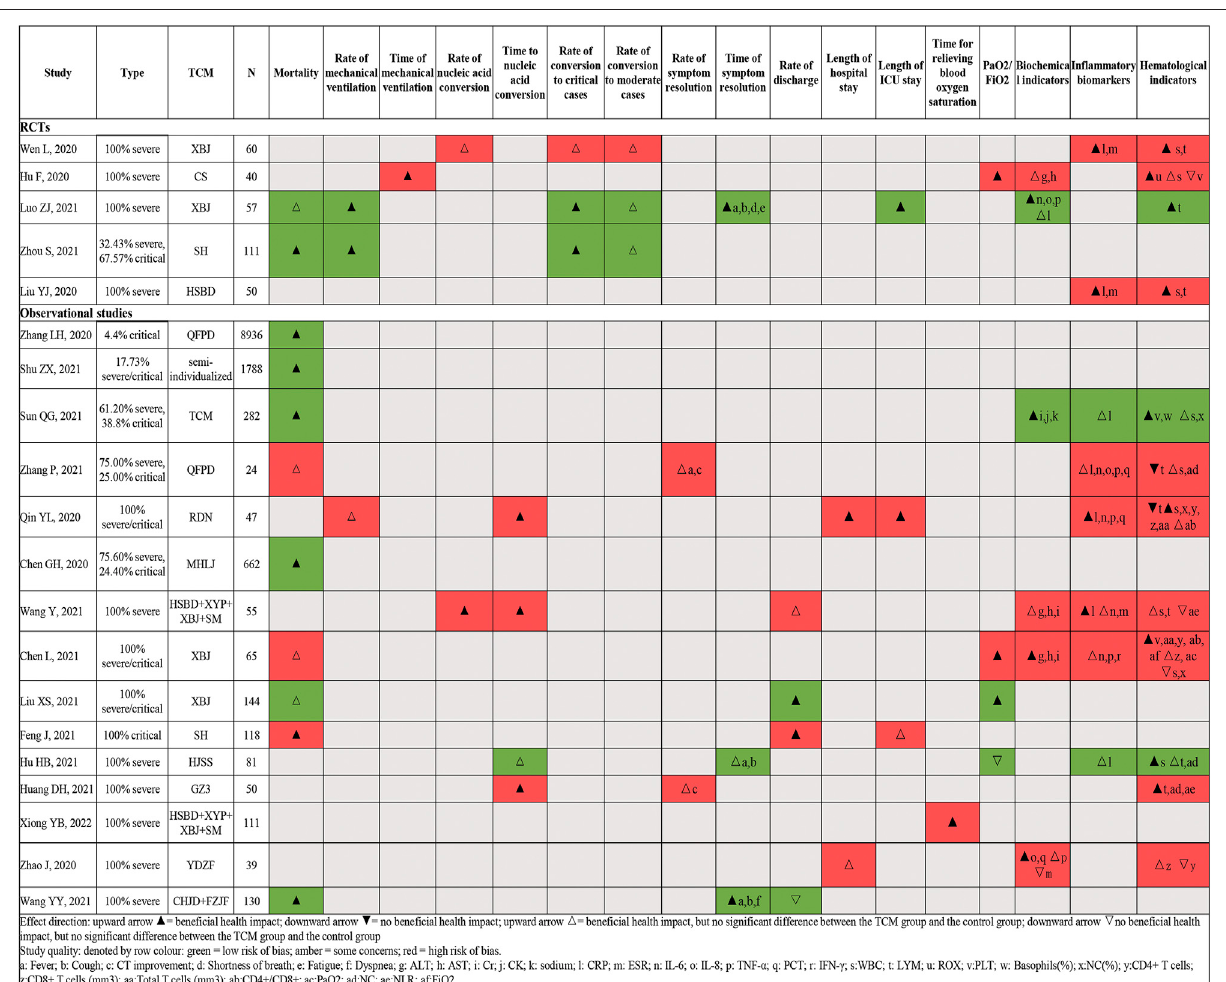
Frontiers in Pharmacology |